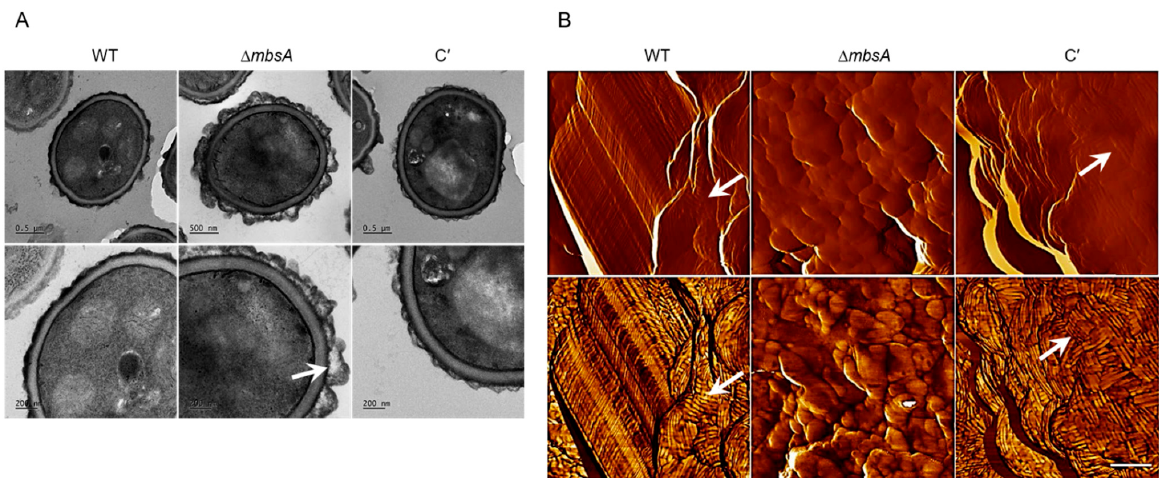
Figure 6. MbsA is needed for proper cell wall architecture and rodlet layer. ( A ) Transmission electron micrographs of conidia. The conidia were harvested from the cells cultured on MMY medium for 5 days, and they were fabricated as ultra-thin specimens for transmission electron microscopy. ( B ) Atomic force microscopy (AFM) image of conidial surface of three strains. Upper: amplitude image; Lower: phase image. Rodlets showed only in WT and C ′ strains (arrows). Bar indicates 100 nm.